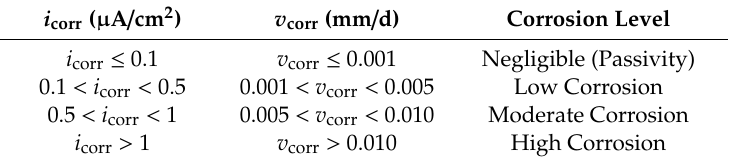
Table 8. Level of corrosion in concrete, corrosion current density ( i corr ) and the corrosion rate ( v corr )